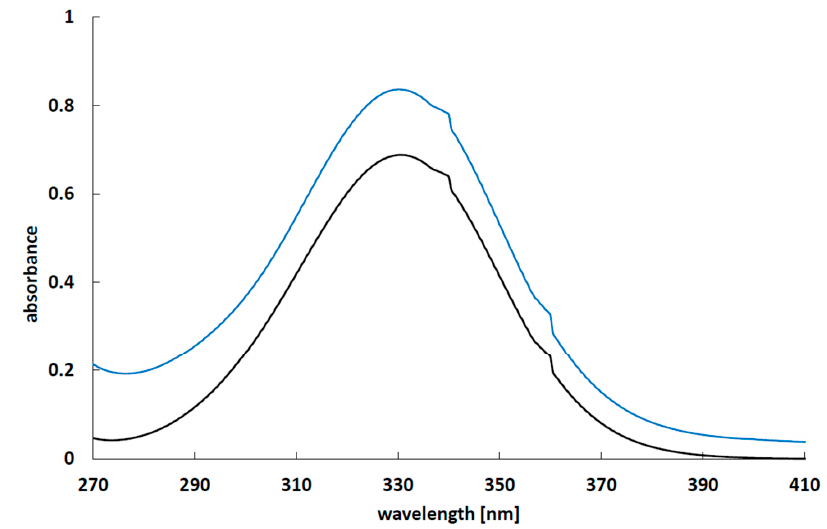
Figure 8. The UV-Vis spectrum of 5-ASA obtained at room temperature in bu ff er solution pH = 7.4, Figure 8. The UV ‐ Vis spectrum of 5 ‐ ASA obtained at room temperature in buffer solution pH = 7.4, the concentration of 5 ‐ ASA was 0.03 mg/mL (black line) and in 2% calcium chloride solution, the the concentration of 5-ASA was 0.03 mg / mL (black line) and in 2% calcium chloride solution, concentration of 5 ‐ ASA was 0.05 mg/mL (blue line). the concentration of 5-ASA was 0.05 mg / mL (blue